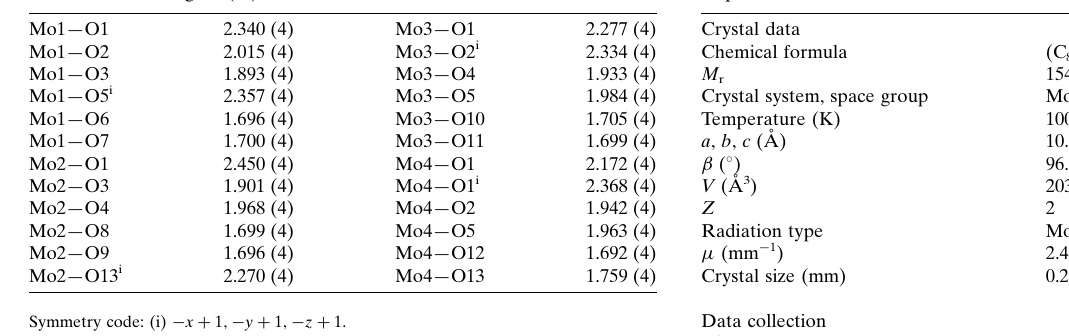
Table 2 Selected bond lengths (A˚